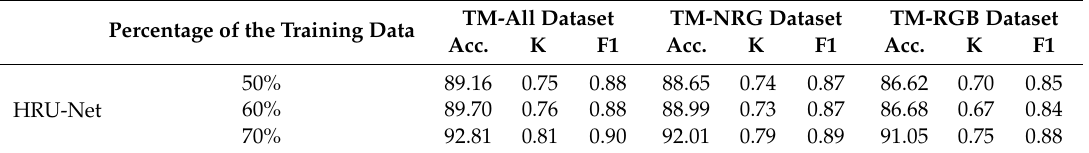
Table 6. The overall accuracy of the HRU-Net under 50%, 60% and 70% training sets. Percentage of the Training Data